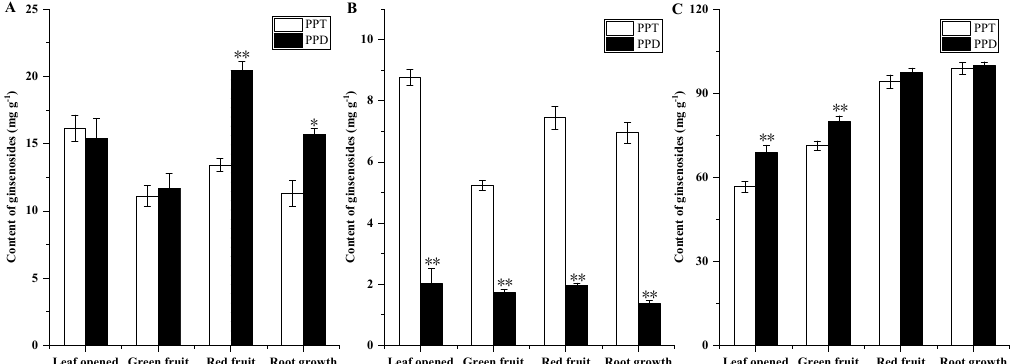
Figure 5. The ginsenoside compositions of the root ( A ), leaf ( B ), and stems ( C ) in the different growth stages. Vertical bars indicate the mean ± standard error from three independent experiments. * indicated that the different growth stages are significantly different at the 0.05 level. ** indicated that the different growth stages are significantly different at the 0.01 level.